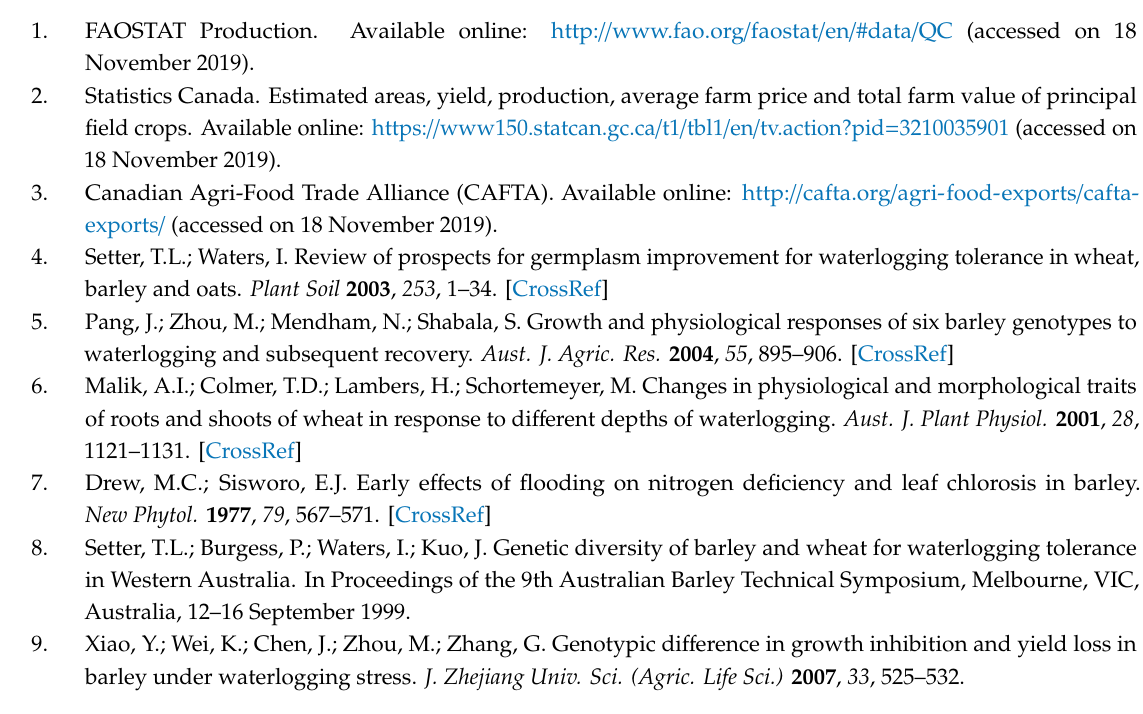
Figure S1: RNA-Seq and qRT-PCR validation data of five genes, Figure S2: Pearson correlation coe ffi cient matrices, indicated by the 4 × 4 darker blue boxes, showing relationships between samples, Table S1: List of top highly expressed di ff erentially expressed genes (logFC ≥ ± 4 and adjusted p < 0.05) in the roots of Deder2 after 72 and 120 h of waterlogging, Table S2: Selected di ff erentially expressed genes with altered expression in roots of waterlogged Yerong (72 h) and Deder2 (72 and 120 h) seedlings that are involved in major metabolism pathways, Table S3: Selected di ff erentially expressed genes with altered expression in roots of waterlogged Yerong (72 h) and Deder2 (72 and 120 h) seedlings that are involved in hormones-related genes and reactive oxygen species (ROS) production pathways, Table S4: Summary of sequence assembly reads after Illumina sequencing (average of 4 biological replicates), Table S5: Overview of mapping status by RNA-Seq (average of 4 biological replicates), Table S6: Primer sequences and amplification e ffi ciency for five target waterlogging related genes and three reference